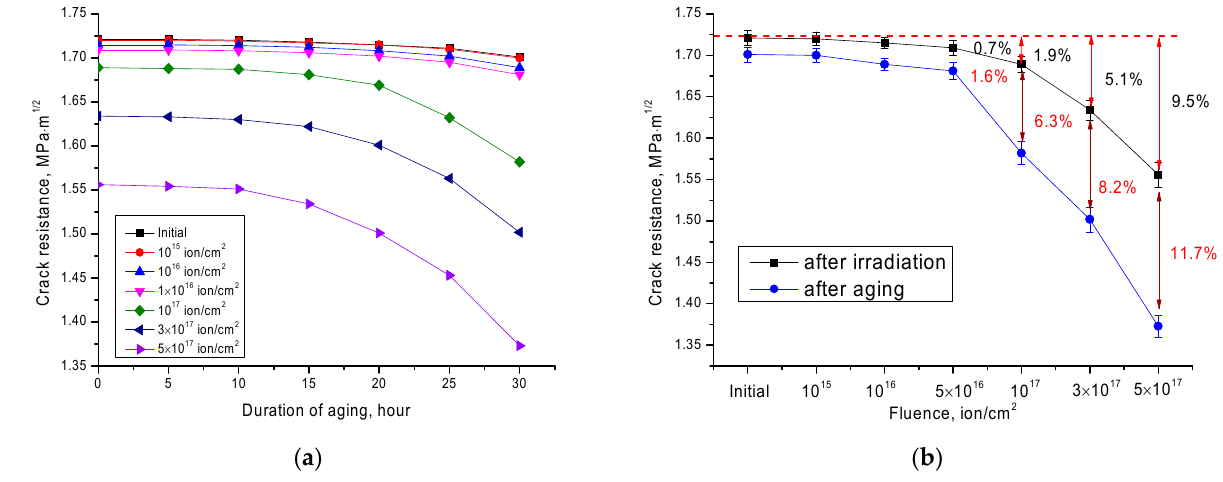
Figure 11. ( a ) Results of the change in crack resistance depending on the time of aging tests; ( b ) Results of the change in crack resistance after irradiation and after aging.